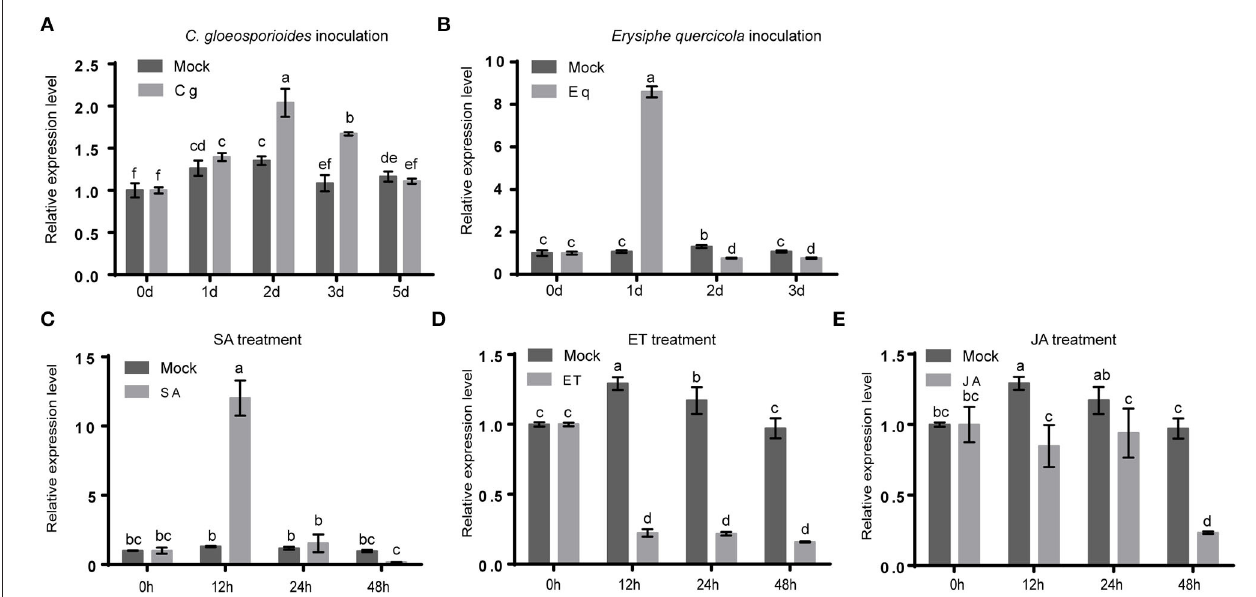
FIGURE 7 | Expression profiles of HbMYB8-like in rubber tree leaves with phathomycete inoculation and phytohormones treatments. Data are shown as the means ± SD from three independent experiments, and columns with different letters indicate a significant difference ( P < 0.05). (A) The expression profile of HbMYB8-like to C. gloeosporioides. (B) The expression profile of HbMYB8-like to E. quercicola. (C) The expression profile of HbMYB8-like to SA. (D) The expression profile of HbMyb8-like to ET. (E) The expression profile of HbMyb8-like to